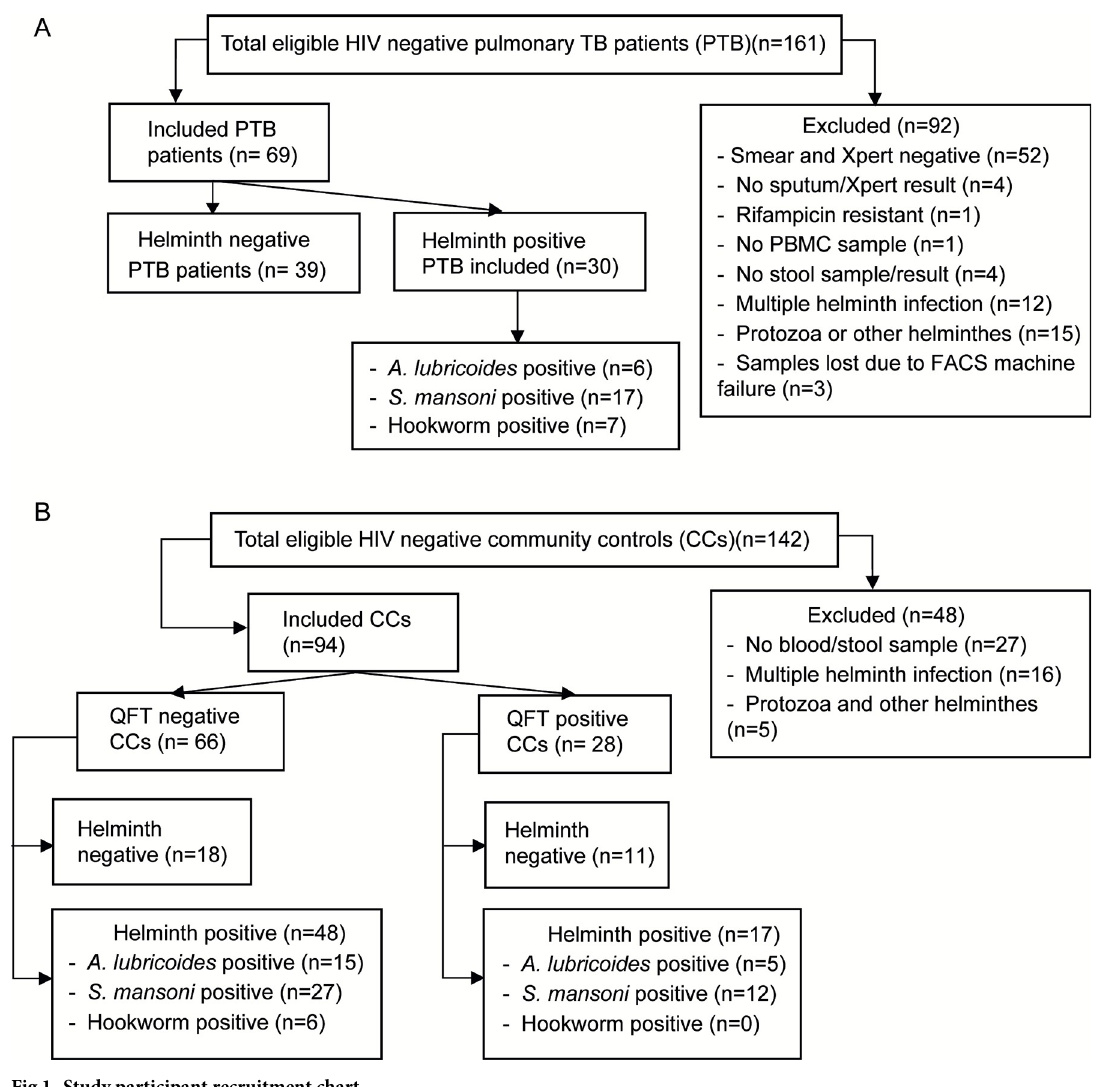
Fig 1. Study participant recruitment